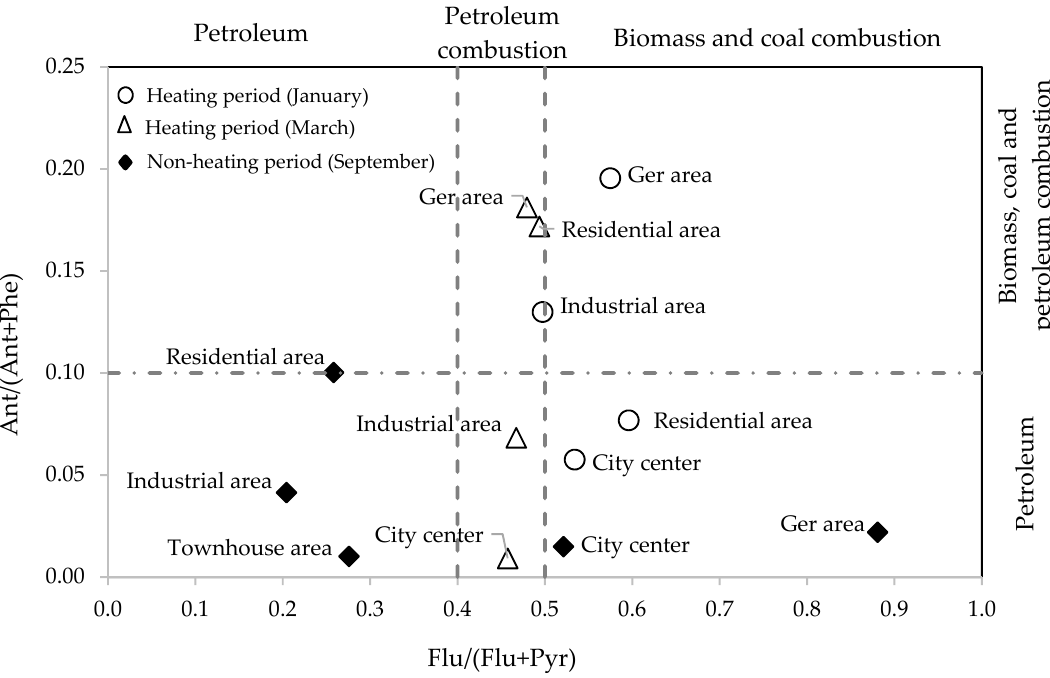
Figure 5. Cross plot of the diagnostic ratios for the sources of PAHs in winter and late summer.